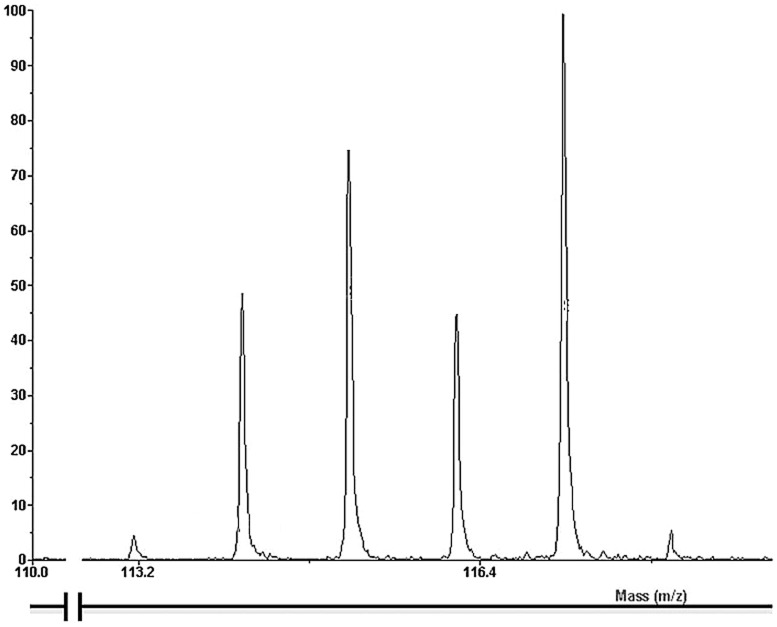
Reporter ion pattern of Peroxiredoxin I (peptide LVQAFQFTDK).Peaks at 114, 115, 116 and 117 represent the group of young non-susceptible after acute smoking; young non-susceptible at baseline, young susceptible after acute smoking and young susceptible at baseline, respectively.